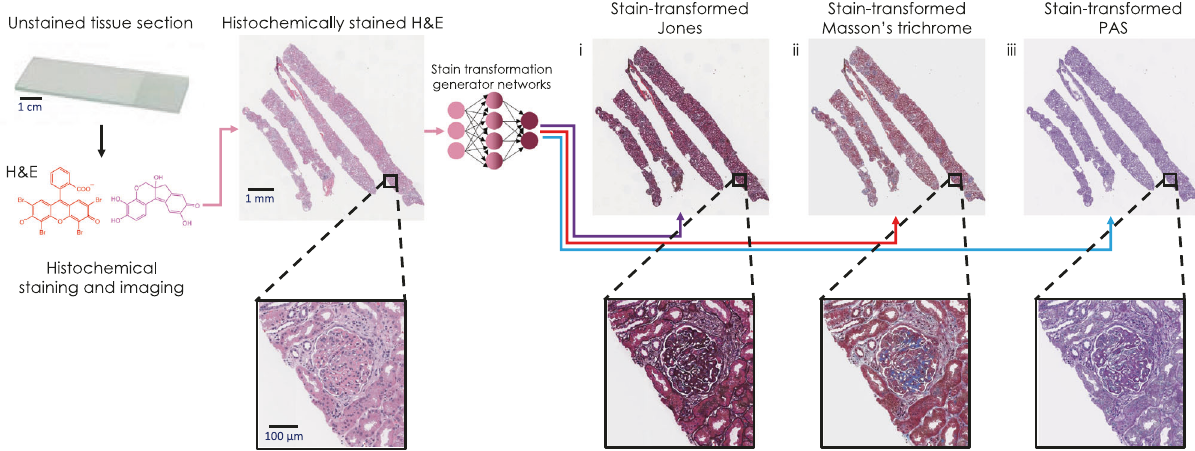
Fig. 1 Overview of deep learning-based H&E stain transformation into special stains. Histochemical staining of H&E is digitally transformed using a deep neural network into the special stains: (i) generation of JMS (purple arrow); (ii) generation of MT (red arrow); (iii) generation of PAS